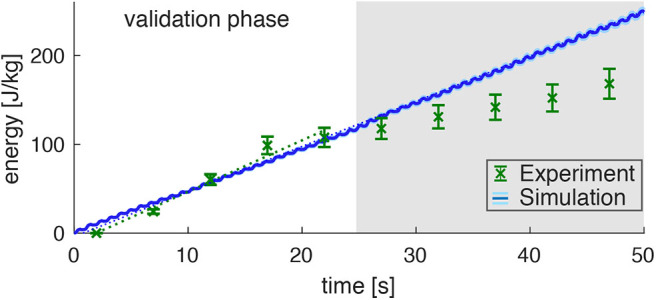
Prediction of the energy consumption by the model (mean: blue line, standard deviation: very small light-blue shade around the blue line) compared to the measured energy consumption in the experiments (derived from the PCr decay; green data points) for dynamic plantarflexion. The model predicts the energy rate (Ėsim=5.081±0.064Jkg-1s-1, linear fit, dotted blue line) as the sum of activation-maintenance heat, shortening-lengthening heat, and mechanical work performed by the muscle fibers: Ė = ḣAM + ḣSL +ẇCE. The experimental data shows a similar energy rate (Ėexp=5.8±1.8Jkg-1s-1, linear fit, dotted green line) during the first 25s (validation phase). During this time, the PCr decay dominates the ATP re-synthesis. Afterwards, the aerobic and anaerobic metabolism additionally contributes (see the progressing pH depletion in Figure 4B). Hence, after 25s not the whole energy consumption is reflected by the measured [PCr] reduction. The error margin for the simulation (light blue) was determined by a Monte-Carlo simulation based on the estimated errors of the subject specific parameters determined in Experiment 1. The error for the experimental energy consumption estimates the maximum error of the 31P-MRS.